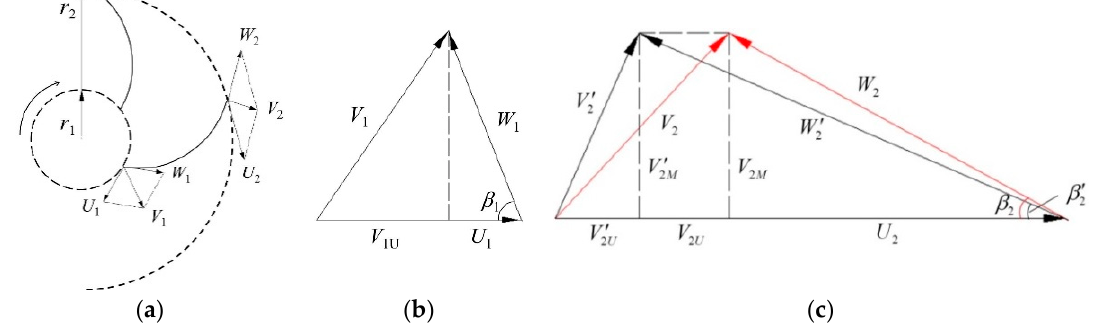
Figure 6. Velocity triangles: ( a ) Blade to blade impeller flow channel; ( b ) Inlet velocity triangle; ( c ) Outlet velocity triangle.